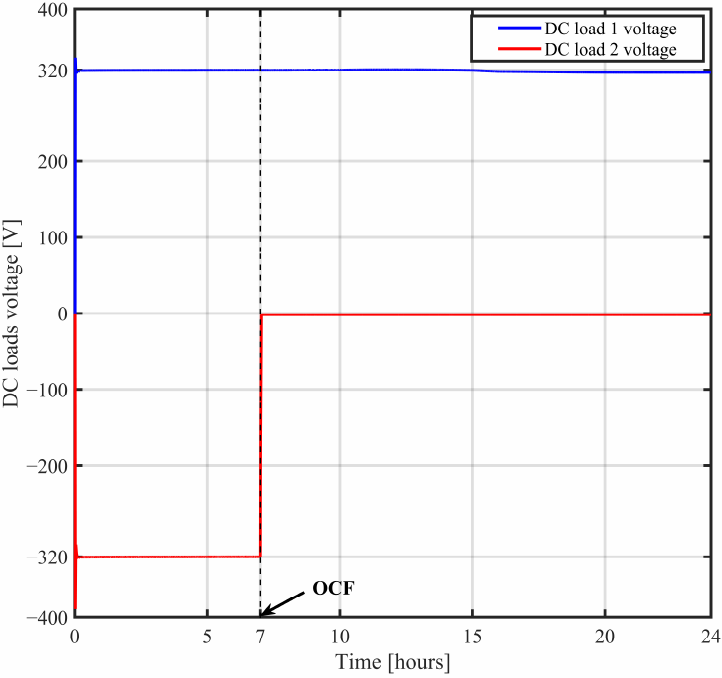
Figure 23. DC load voltage values in the LVDC distribution under OCF.